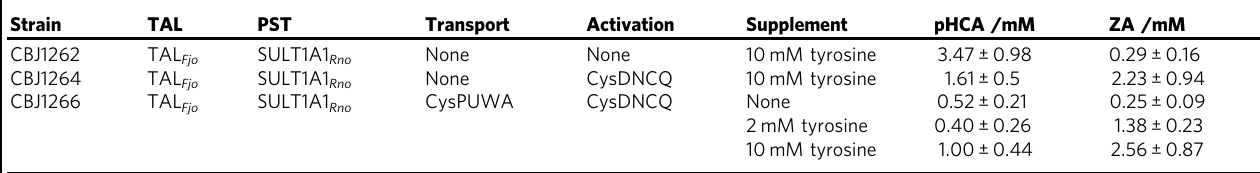
Table 2 Production of zosteric acid from glucose or tyrosine Strain